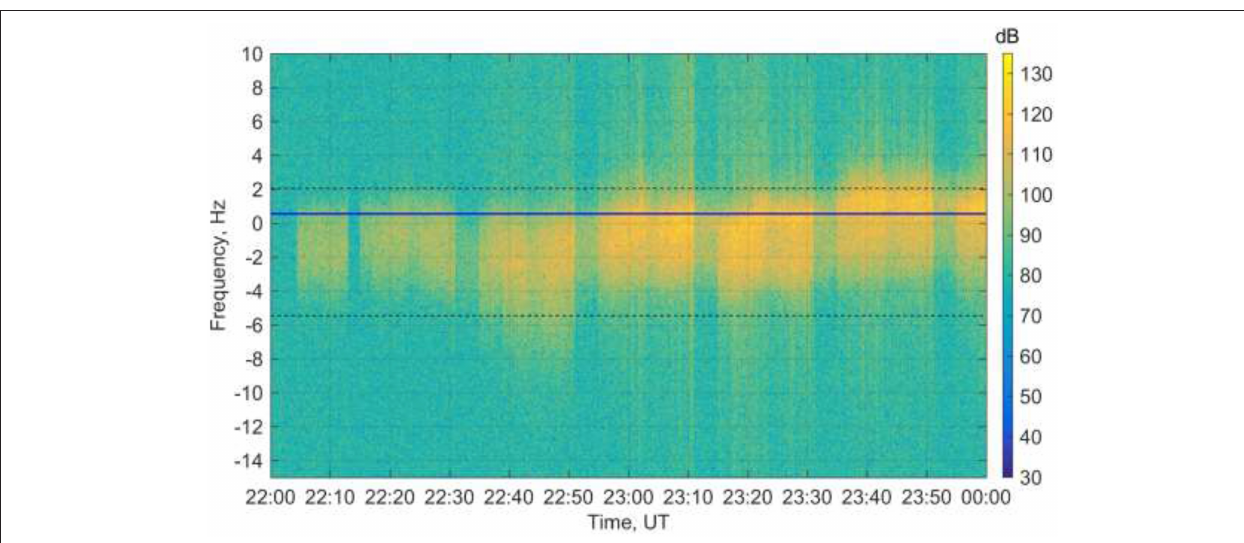
FIGURE 9 | Spectrogram of the Arecibo heater signal received at UAS on March 17, 2018.